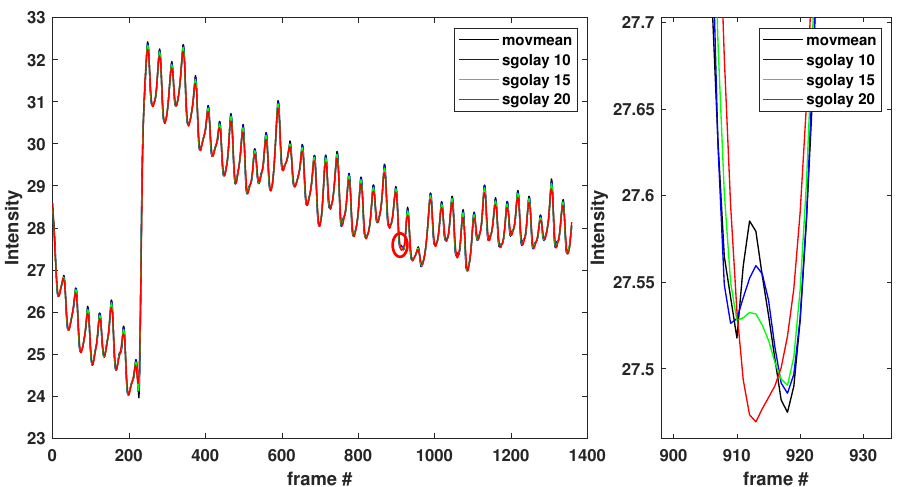
Figure 3. ( Left ): signal intensity obtained with the moving-average filter applied with and without the Savitzky–Golay filter (with several sliding window lengths). The red circled peak at frame 915 is magnified on the right. The red circled peak at frame 915 shows that a sliding window of length 20 across neighboring data elements gives smoother results.